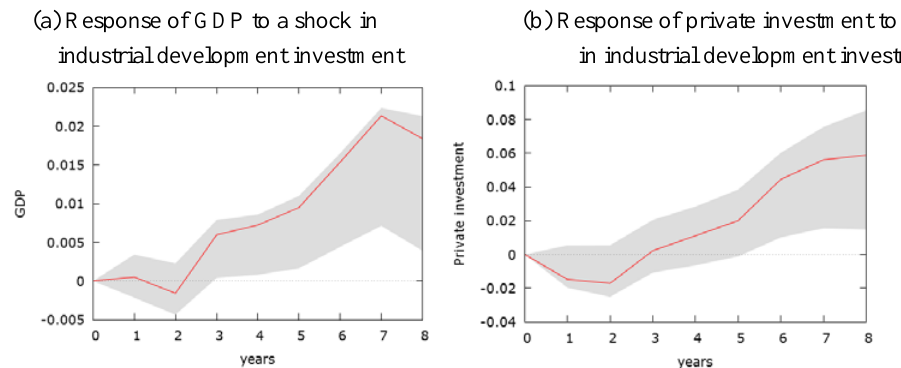
Figure 2 : IRFs of the industrial development investment